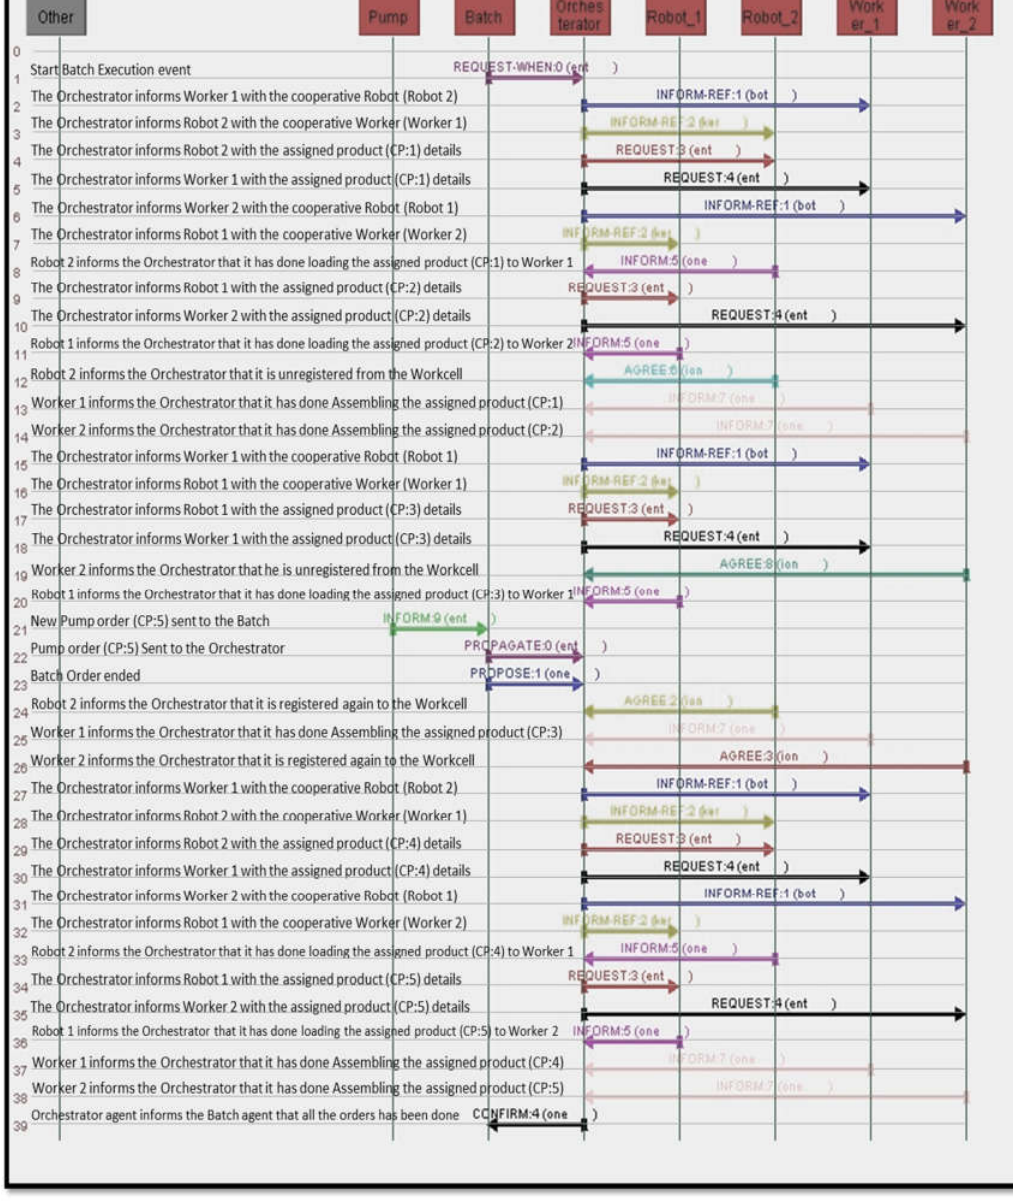
Figure 11 . Operational Resources Interaction to Execute the Case Study. Figure 11. Operational Resources Interaction to Execute the Case